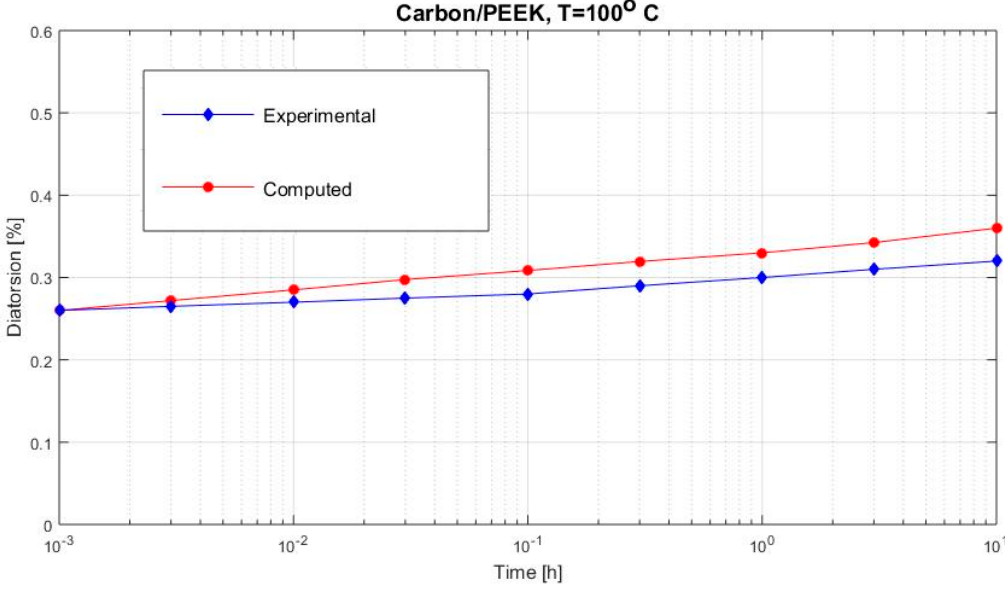
= τ 6 MPa at 100 °C). 12